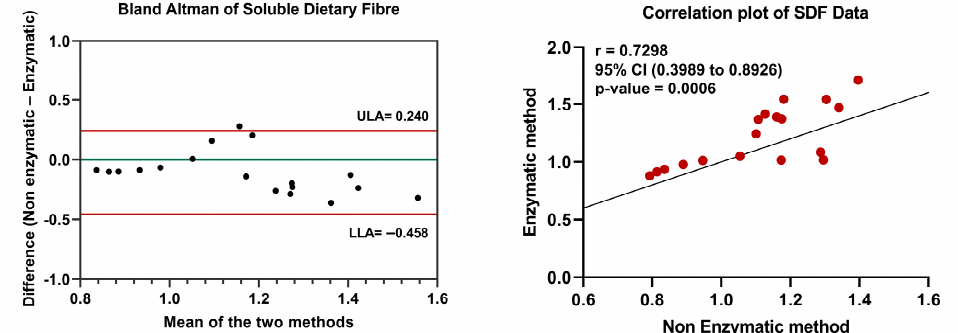
Figure 2. Comparison of SDF data from enzymatic and non-enzymatic methods. Bland–Altman plot was created by plotting the average and difference between the enzymatic and non-enzymatic methods. ULA—Upper limit of agreement; LLA—Lower limit of agreement. Pearson’s correlation coefficient was calculated for SDF data. Statistical significance was set at p -value ≤ 0.05.